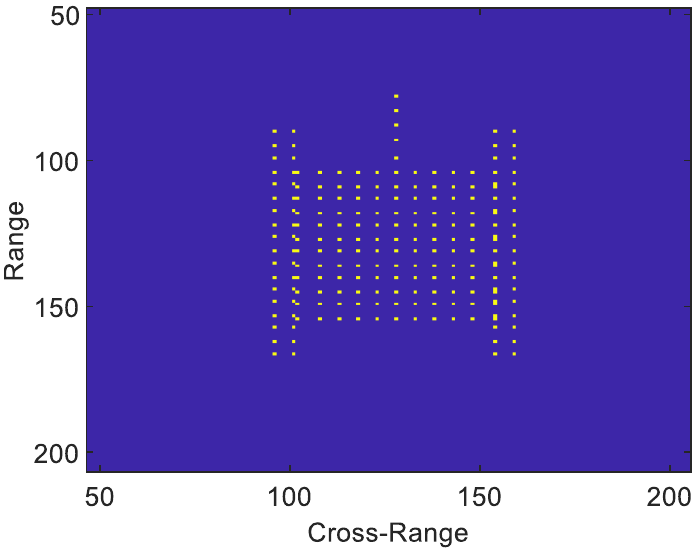
Figure 4. Schematic diagram of a tank model.